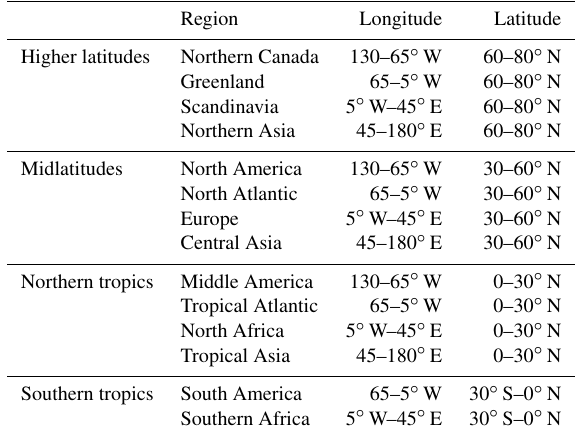
Table 1. Definition of different regions covered by IAGOS flight